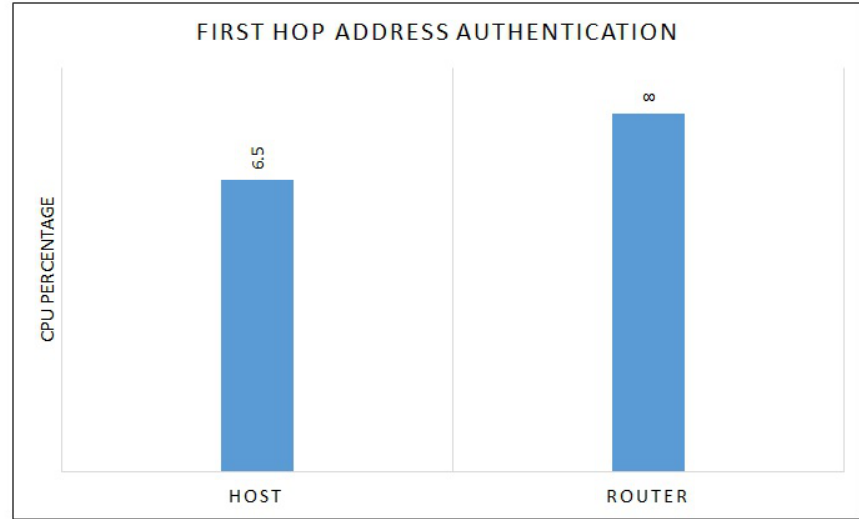
Figure 12. CPU load based on first-hop